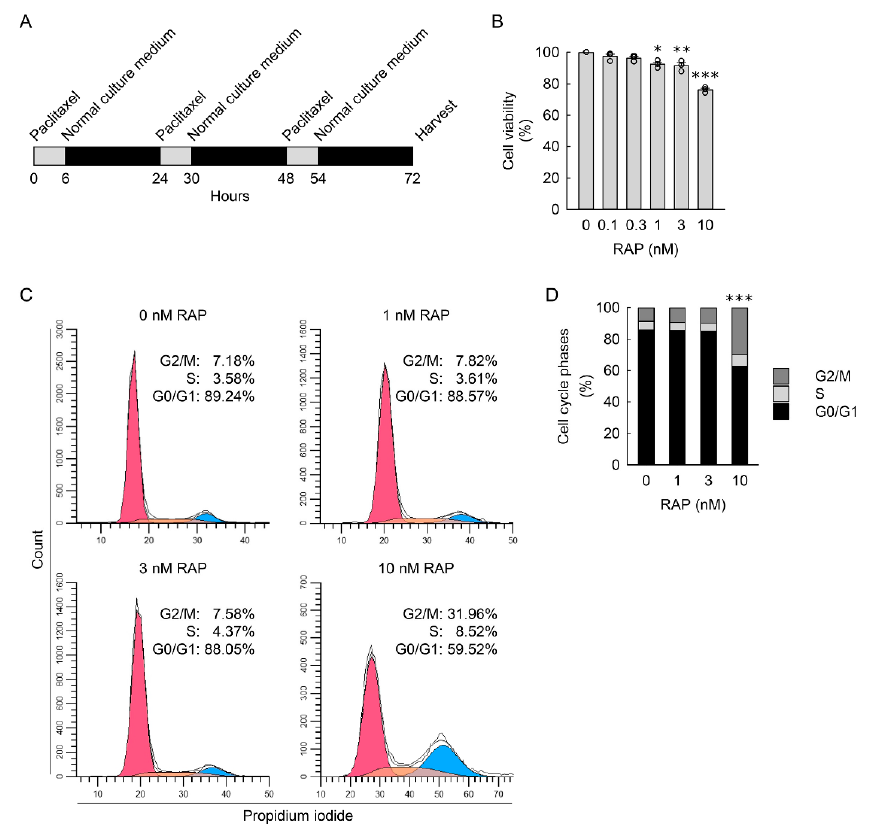
Figure 7. Repeated administration of paclitaxel (RAP) induces G2/M cell cycle arrest. ( A ) Experi- mental timetable for RAP in normal rat kidney fibroblast NRK-49F cells. The cells were treated with 0, 0.1, 0.3, 1, 3, or 10 nM paclitaxel, a microtubule-stabilizing agent, in normal culture media for 6 h,